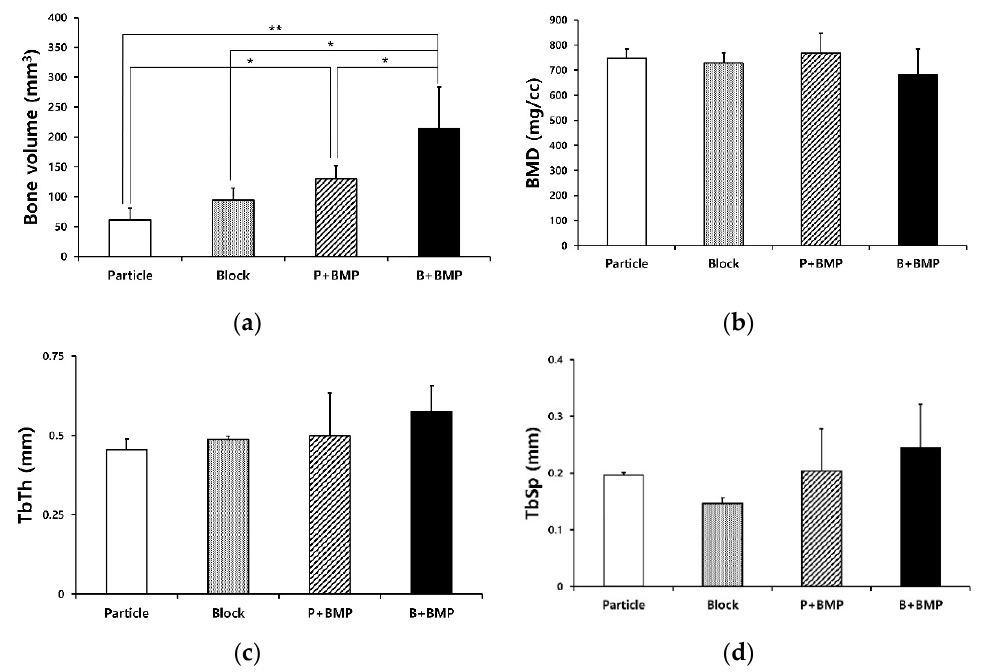
Figure 3. Micro-computed tomography analysis: ( a ) Bone volume (BV), ( b ) Bone mineral density (BMD), ( c ) Trabecular thickness (TbTh), and ( d ) Trabecular spacing (TbSp) of the the particle (P), block (B), P+ bone morphogenetic protein (BMP), and B+BMP groups. Significant differences were observed in the BV values (* p < 0.05, ** p < 0.001).